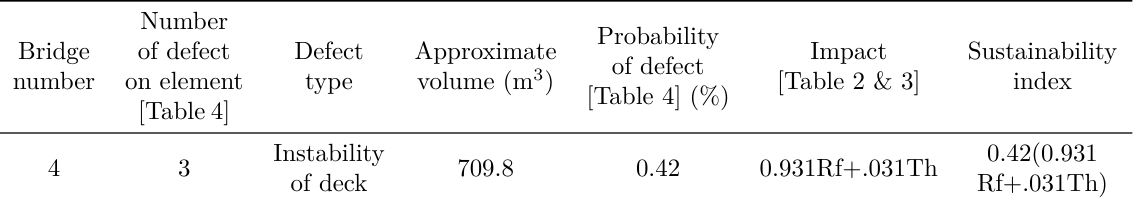
Table 5. Sustainability index for a bridge in case